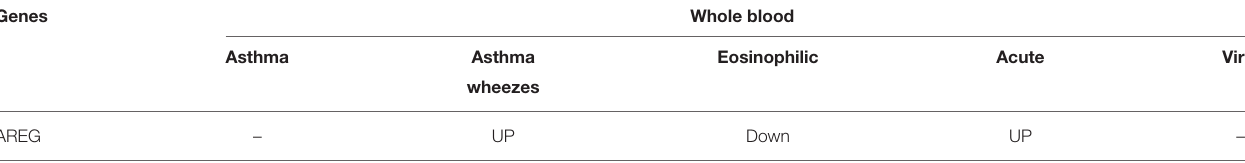
TABLE 7 | Summary of in silico analysis of the AREG genes in blood of asthmatic patients in different settings compared to healthy controls. Genes Whole blood Asthma Asthma Eosinophilic Acute Viral wheezes AREG – UP Down UP